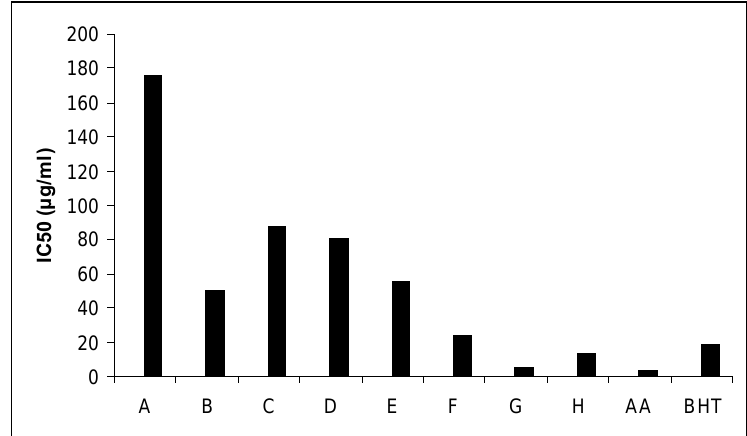
Figure 1. Free radical scavenging activities, where: AA stands for Ascorbic acid; (A) Origanum dictamnus; (B) Eucalyptus globules; (C) Sideritis cretica; (D) Origanum vulgare; (E) Phlomis cretica; (F) Phlomis lanata; (G) Nepeta melissifolia; (H) Mentha pulegium. BHT, butylated hydroxytoluene.